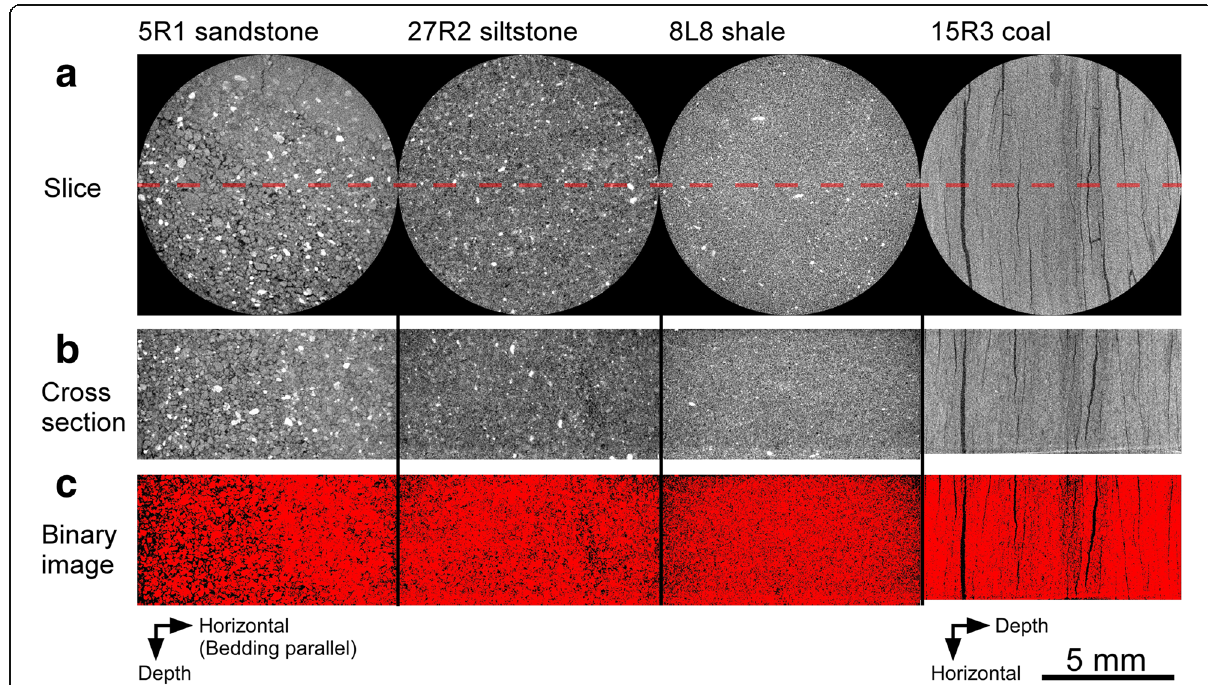
Fig. 8 μ X-CT image of four core samples used for permeability tests. a Original images sliced in the vertical direction relative to the flow direction. The sliced images for Cores 5R1, 27R2, and 8L8 are parallel to the bedding, and the image for Core 15R3 is perpendicular to the bedding. b Modified sliced images of the cut section, shown as a broken line in ( a ), parallel to the flow direction. c Binary images of ( b ), adjusted based on initial porosity